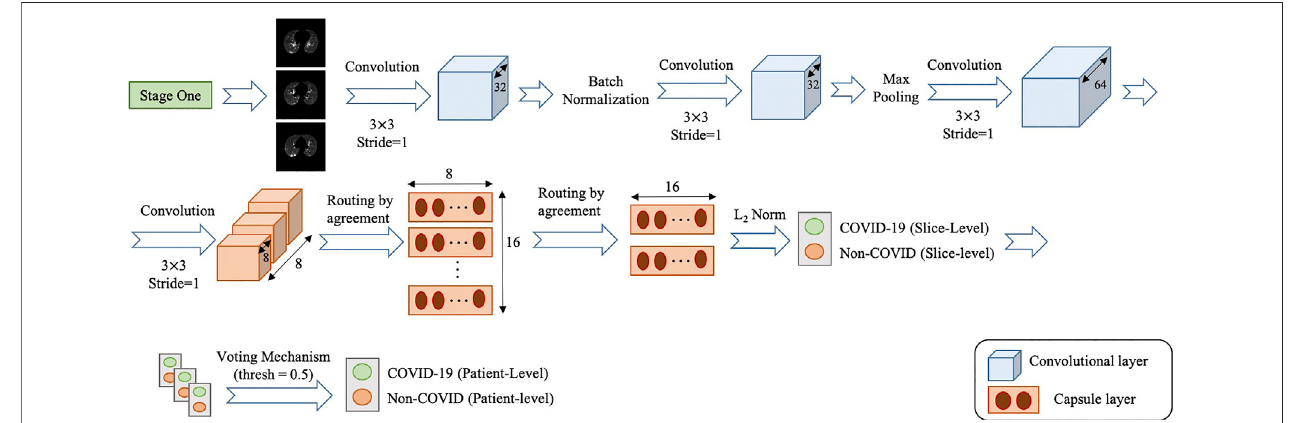
FIGURE 4 | Architecture of the COVID-FACT at stage